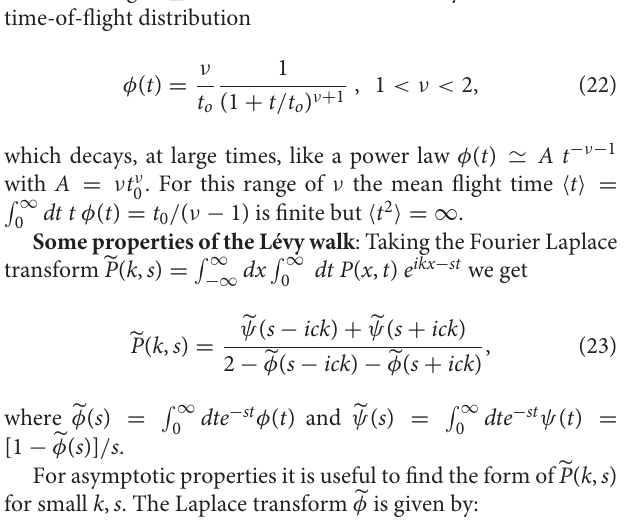
FIGURE 6 | Plot of the scaled distribution t 2 / 3 P ( x , t ) vs. x / t 2 / 3 of the Lévy walk on the open line for ν 3 / 2 at three different times. Also shown is a plot of the = Lévy-stable distribution. The inset shows a plot of the mean square displacement and the fourth moment and a comparison with the exact asymptotic forms (dashed lines) given by Equations (27, 28). In all plots the time t o and c are set to